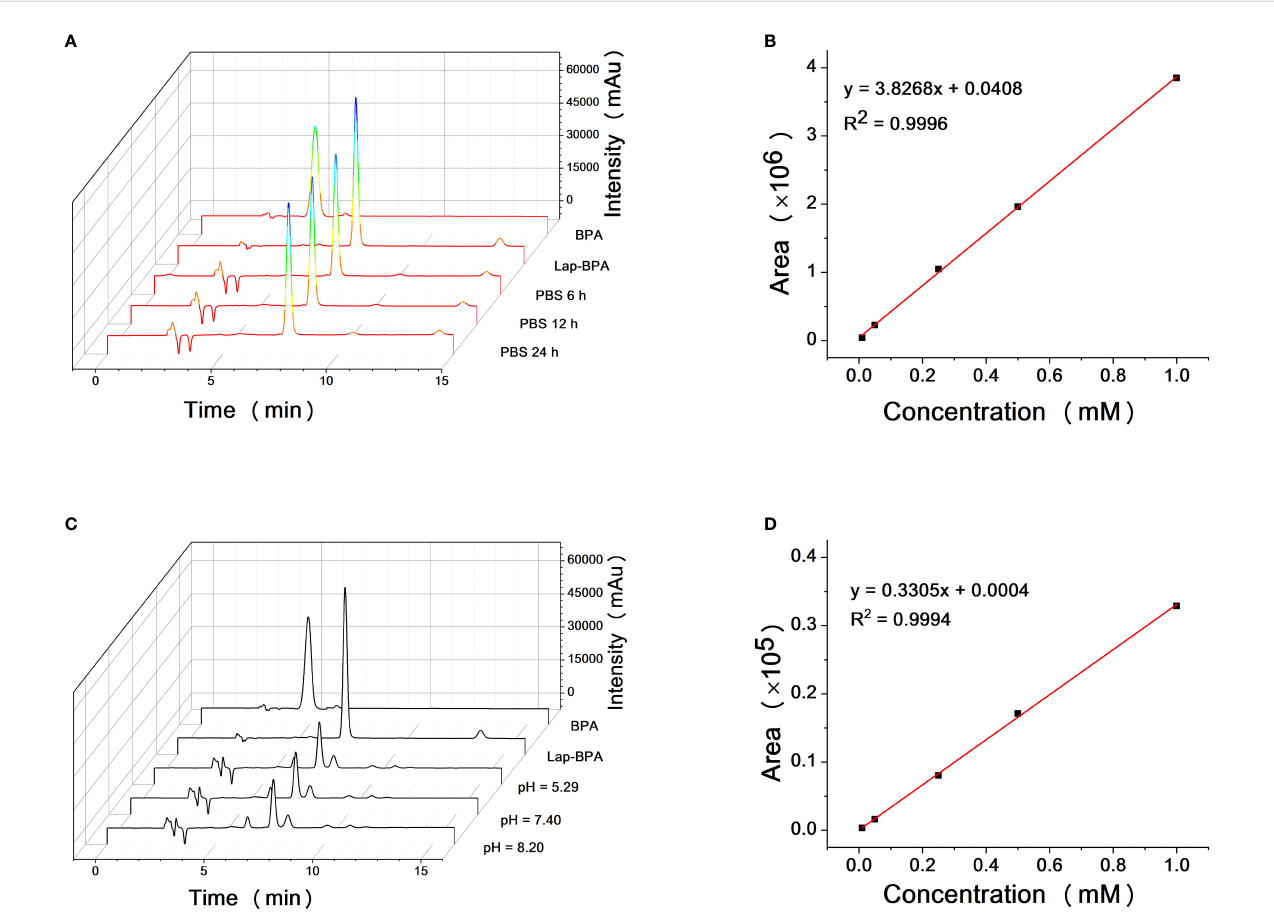
FIGURE 4 Solubility and structural stability of Lap-BPA under physiological conditions. (A) The retention time of Lap-BPA after dissolution in PBS. Correlation curve of integral area with Lap-BPA concentration (B) and BPA (D) concentration. (C) The structural changes of Lap-BPA after 24 hours of mixing in buffer solutions with various pH